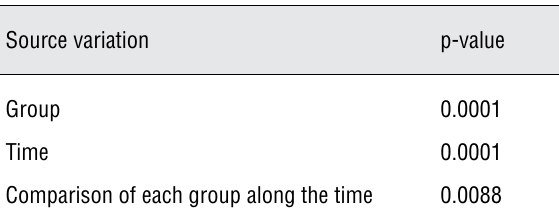
Table 2 - Results of the ANOVA with repeated measures (in ranks) to Maximum